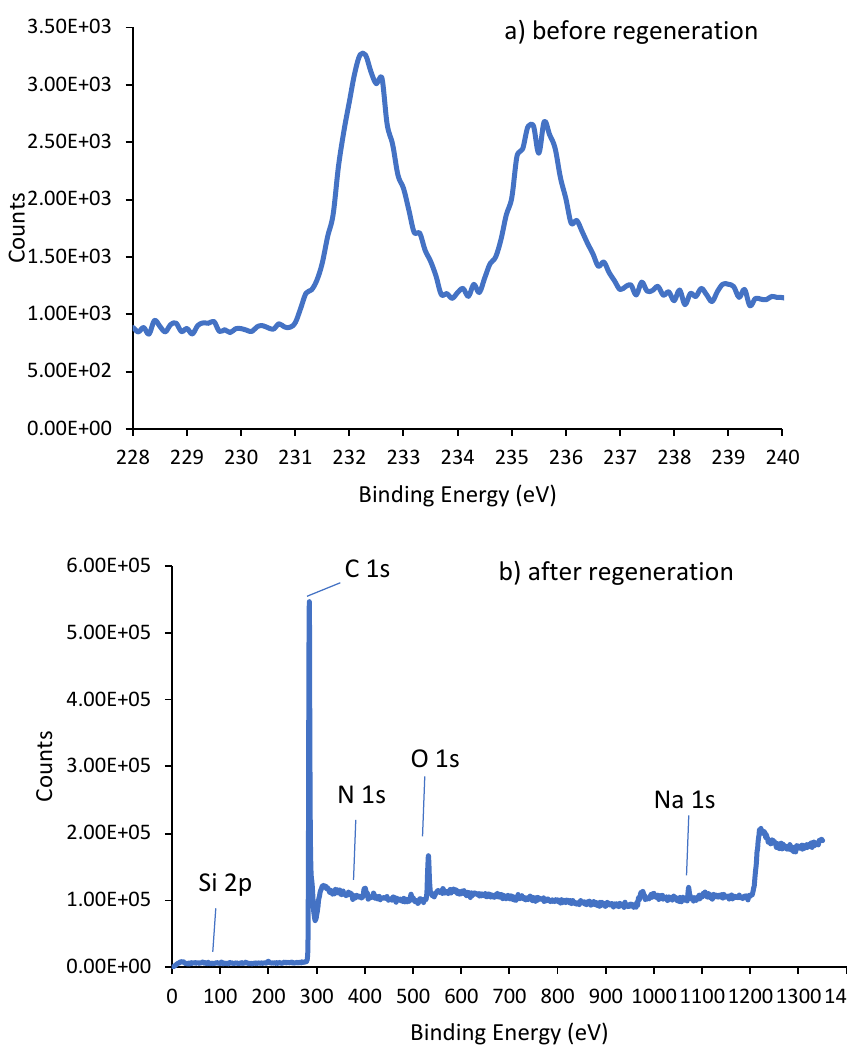
Figure 21. XPS ( a , b ) of CDC samples before and after Mo adsorption.